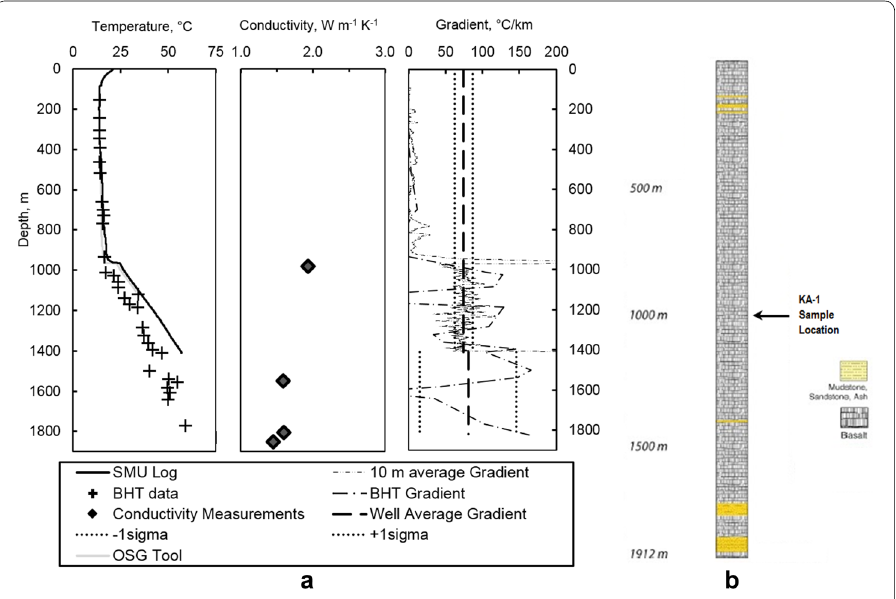
Fig. 2 Temperature logs: a SMU, OSG, and DOSECC BHT temperature data, thermal conductivity measure- ments, and derived gradient, and b generalized lithologic log (Adapted from Shervais et al. (2012,